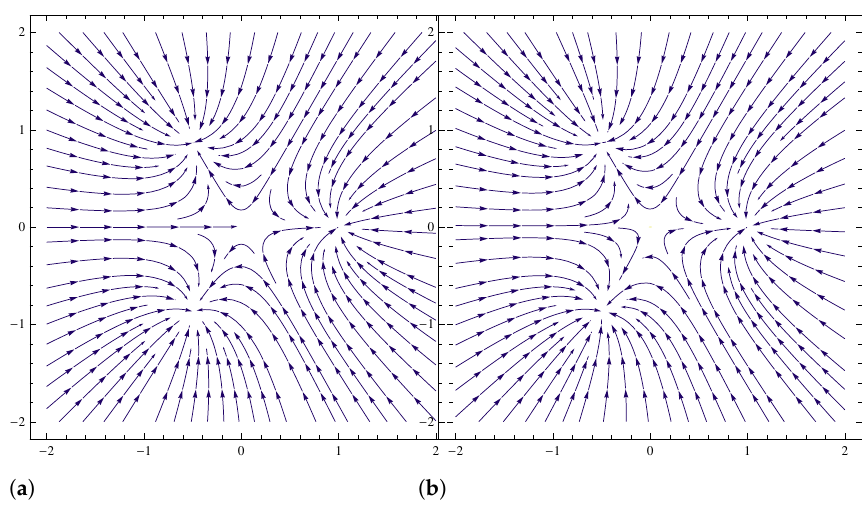
Figure 7. Streamline for F 4 ( z ) = z 3 − 1 by different methods. ( a ) Continuous Newton method (9), ( b ) Proposed Continuous method